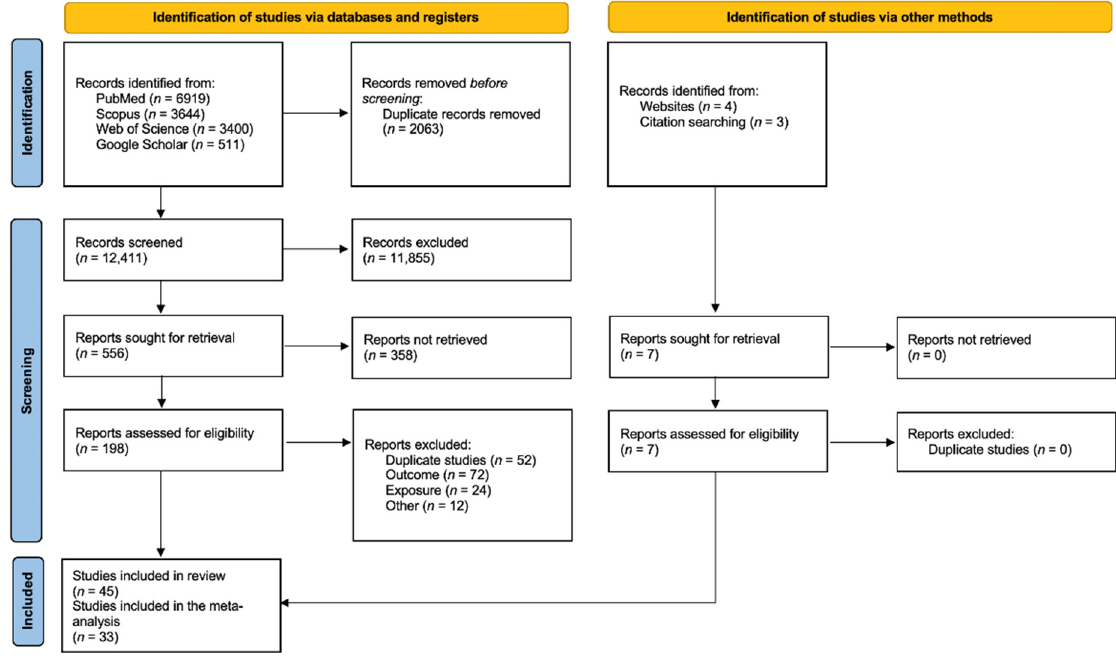
Figure 1. Preferred Reporting Items for Systematic Reviews and Meta-Analyses 2020 flow diagram for new systematic reviews which included searches of databases, registers, and other sources.